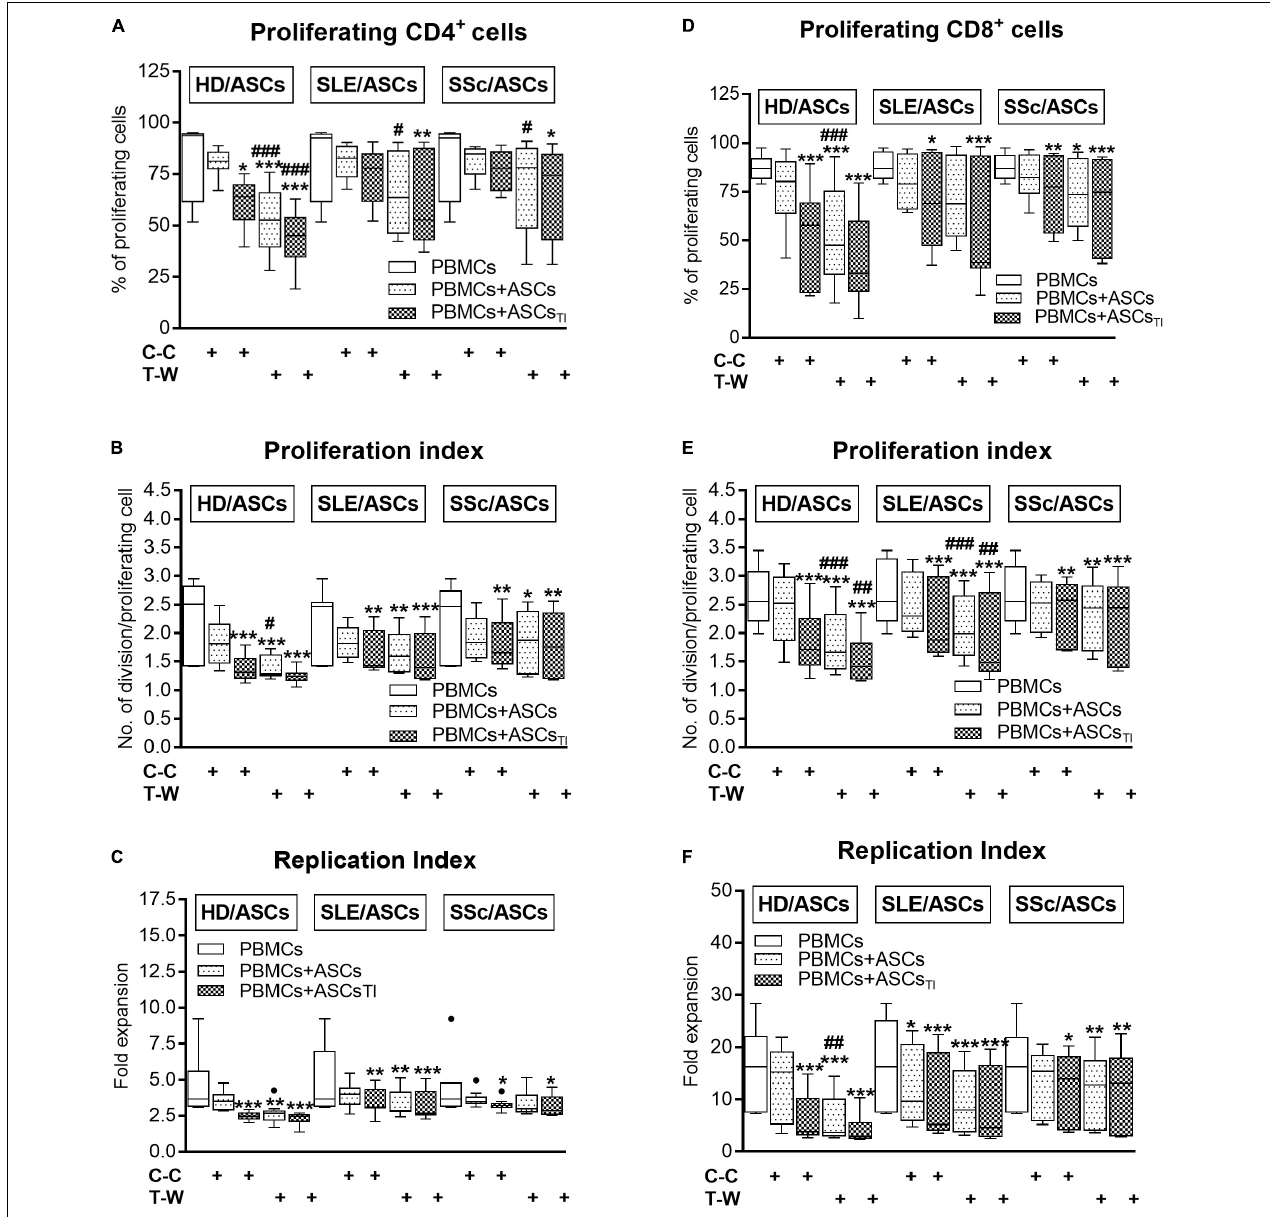
FIGURE 3 | Comparison of ASCs inhibitory effects on (A–C) CD4 + and (D–F) CD8 + T-cell proliferation in cell contact and transwell co-cultures with PBMCs. PHA-activated PBMCs were cultured separately or co-cultured with ASCs or ASCs TI in conditions allowing direct cell contact (C–C) or in a transwell system (T-W). Data, shown as the Tukey’s boxes, are the results of 9 experiments in which 5 HD/ASCs, 9 SLE/ASCs and 9 SSc/ASCs lines were co-cultured with PBMCs isolated from 7 healthy blood volunteers. * P < 0.05, ** P < 0.01, and *** P < 0.001 for comparison of cell co-cultures vs. control separate cultures. # P < 0.05, ## P < 0.01, and ### P < 0.001 for comparison of C-C vs. T-W co-cultures. Other explanations as in Figure 1